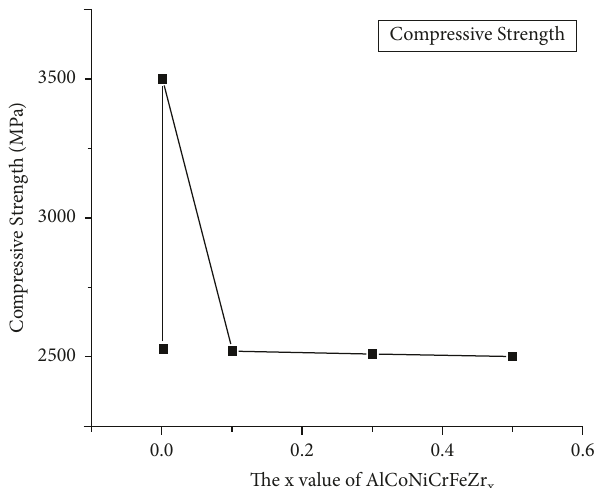
Figure 8: Impact of Zr on plastic strain for AlCoCrFeNiZr [12].